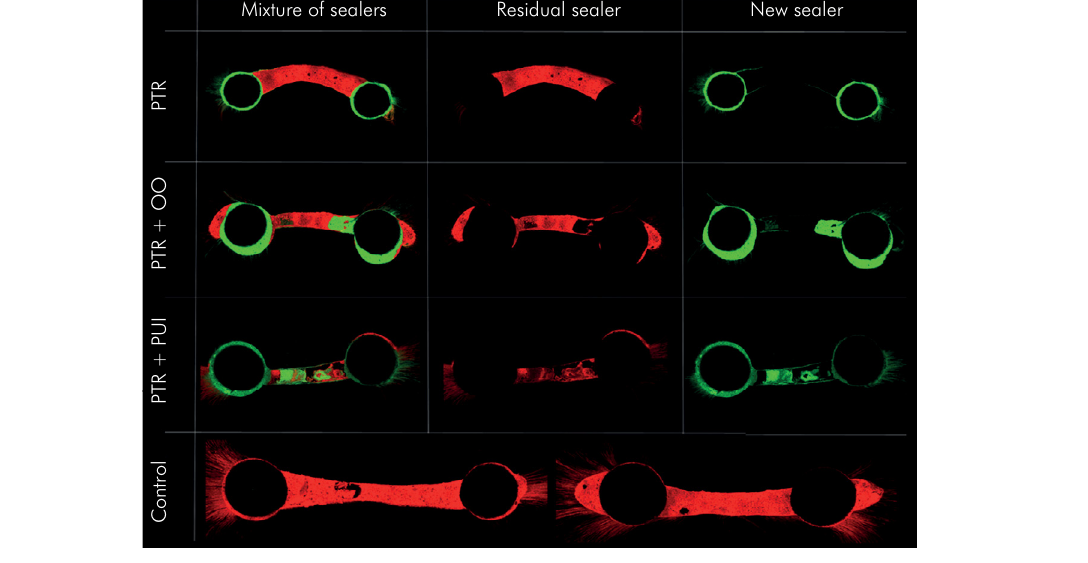
Figure. Representative image of the different groups tested, showing the mixture of sealers, the residual sealer (red), and the new sealer (green), in root canal walls, inside dentinal tubules, and in the isthmus area.